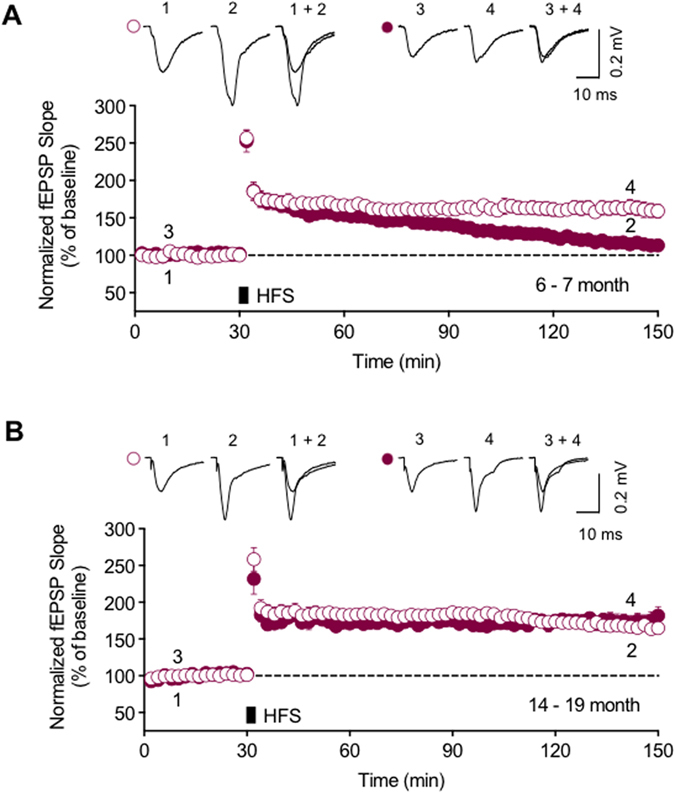
The reemergence of LTP in the hippocampus of aged Tg2576.(A) Applying two trains of tetanus stimuli (10 Hz in  s, 3 s inter-train interval) to the Schaffer collateral pathway evoked LTP in the hippocampal CA1 region in 6–7 months old WT (open circle, n = 8) but did not in Tg2576, where the fEPSP was gradually decreased to the baseline level 2 hours after LTP induction by HFS (closed circle, n = 8). (B) In 14–19 months old animals, LTP was observed in both WT (open circle, n = 7) and Tg2576 (closed circle, n = 7) mice, and their increased fEPSP levels were not significantly different (P > 0.05). Error bars represent standard error of the mean (SEM). fEPSP = field excitatory postsynaptic potential.